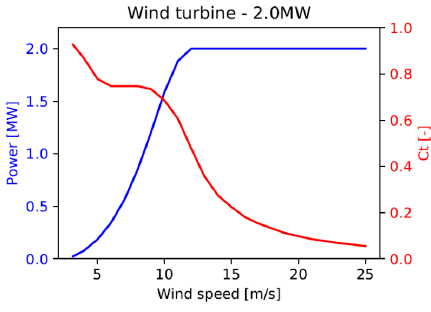
Figure 7. Turbine characteristics.